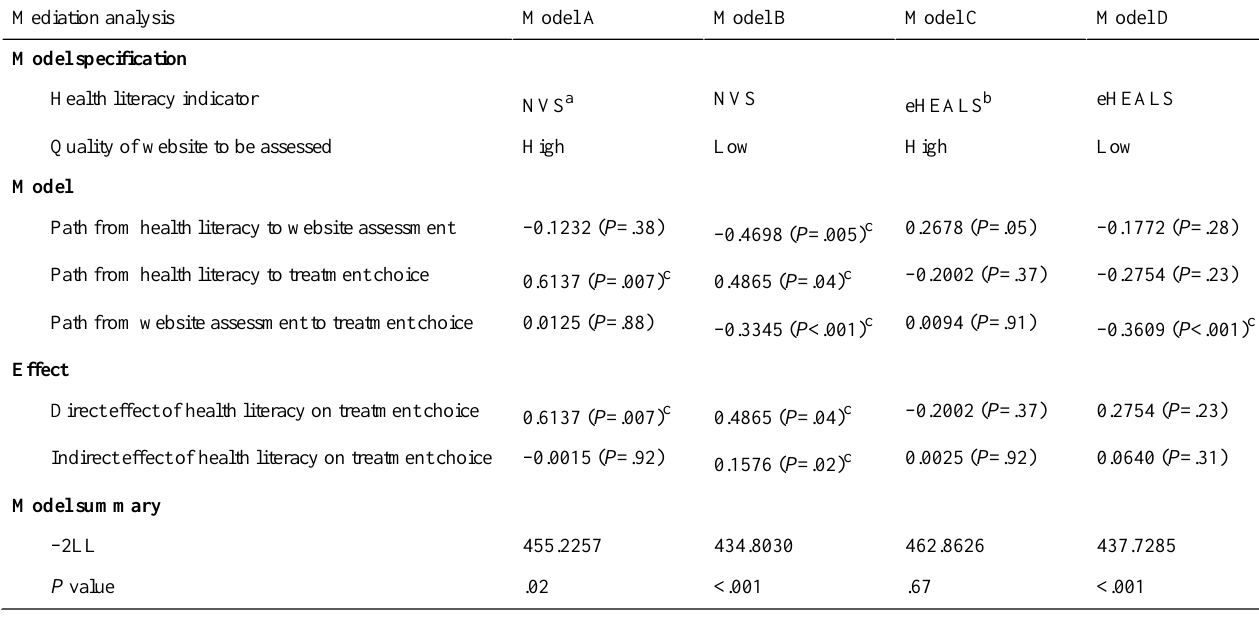
Table 3. Results of mediation analysis.